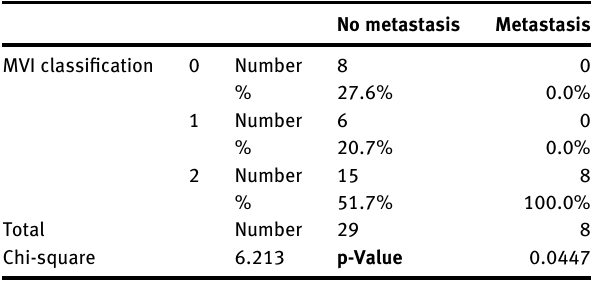
Table  : Association between microvascular invasion classi fi cation and postoperative metastasis.